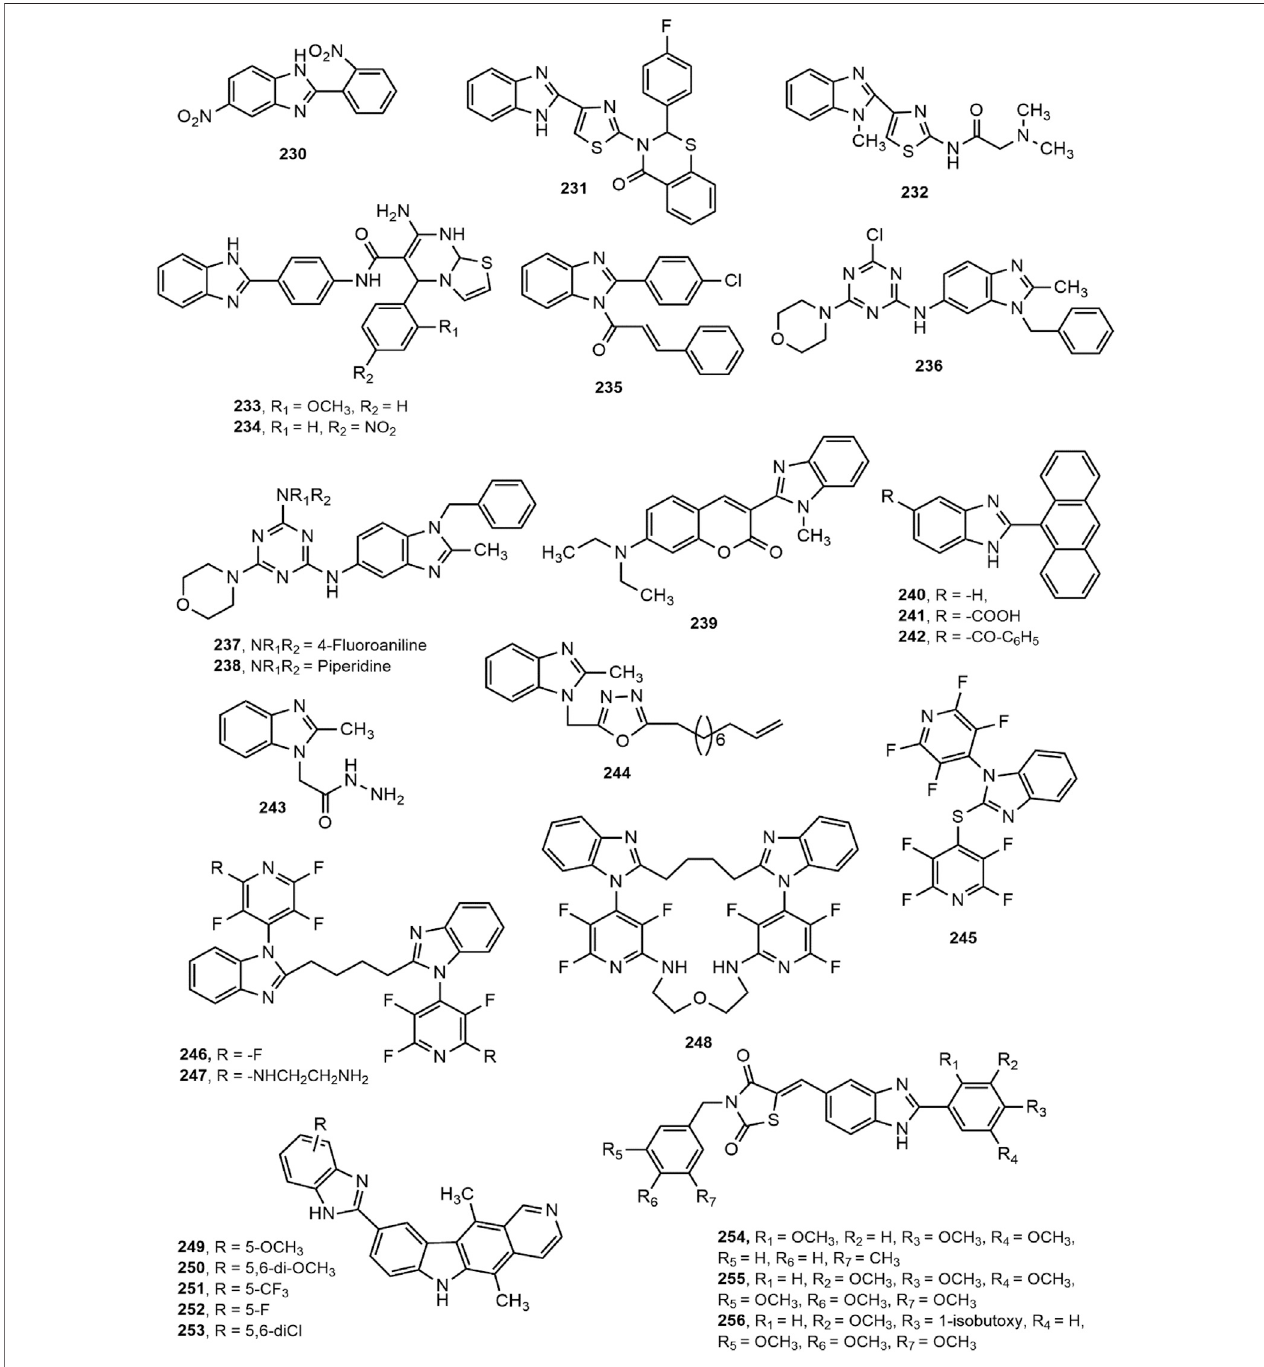
FIGURE 10 | Benzimidazole derivatives with anticancer